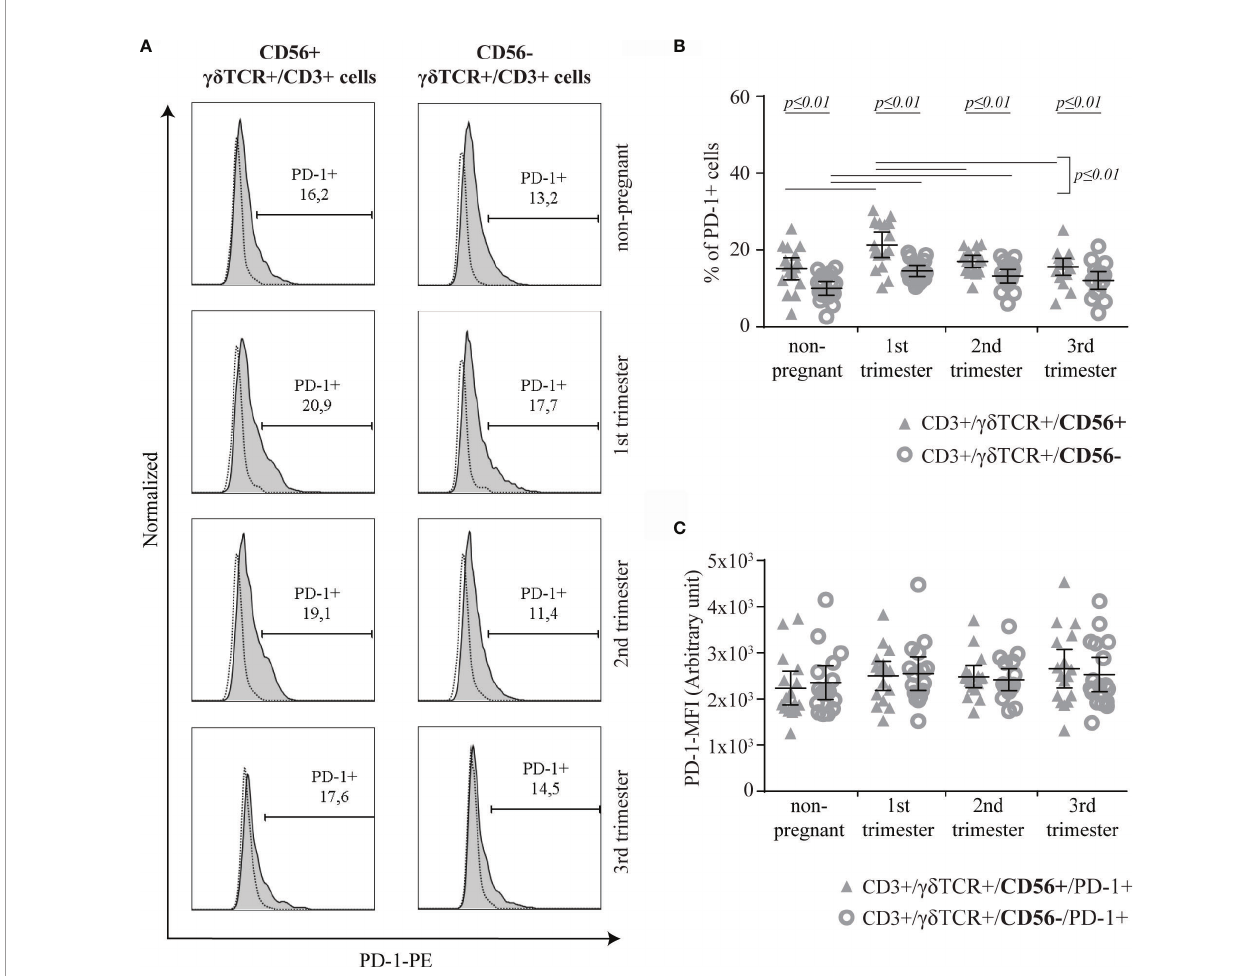
FIGURE 4 | Representative PD-1 histograms (the FMO is depicted by the dotted line) of peripheral blood CD56+ or CD56 − gd T cells (CD3+/ gd TCR+) in non- pregnant and pregnant (1 st , 2 nd , and 3 rd trimester) women (A) Percentage (B) and PD-1-MFI (C) of PD-1+ cells among peripheral blood CD56+ or CD56 − gd T cells (CD3+/ gd TCR+) in non-pregnant (n = 17) and pregnant [1 st (n = 16), 2 nd (n = 17), and 3 rd (n = 17) trimester] women. The mean is depicted by a horizontal line with the 95% con fi dence interval represented by whiskers. The individual data points are shown as triangles (CD3+/ gd TCR+/CD56+ or CD3+/ gd TCR+/CD56+/PD-1+, respectively) or circles (CD3+/ gd TCR+/CD56 − or CD3+/ gd TCR+/CD56 − /PD-1+, respectively). Statistical analysis was performed by using the paired-samples-t-test to compare data between the CD56+ and CD56 − gd T cell population and the unpaired-samples-t-test to compare within the same population but at different timepoints. Signi fi cant differences are depicted by a horizontal line above the respective